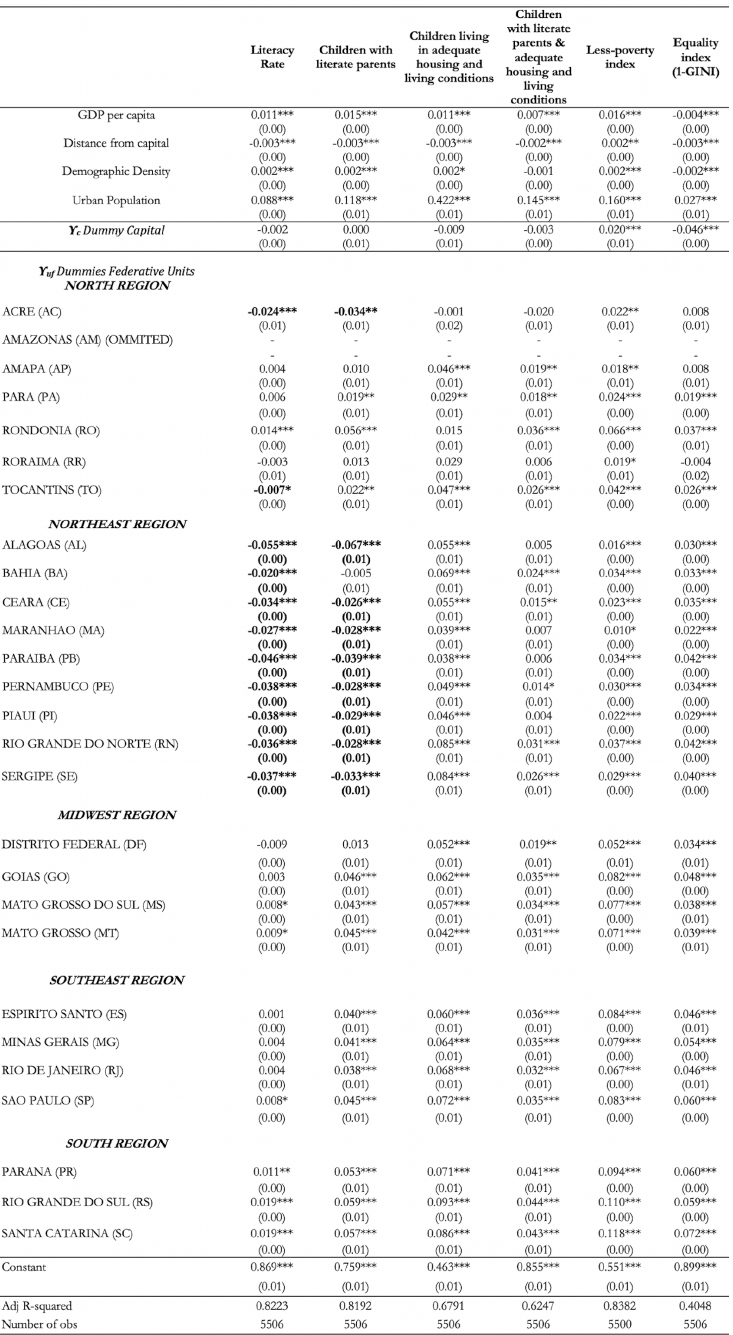
Table 14: Social Regressions MODEL